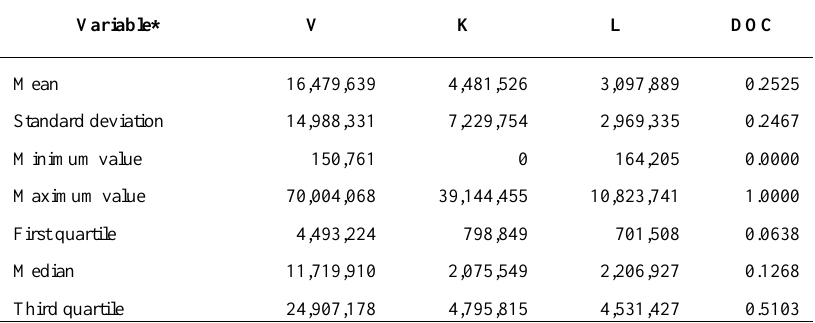
Table 3. Summary statistics of the main variables used in the analysis